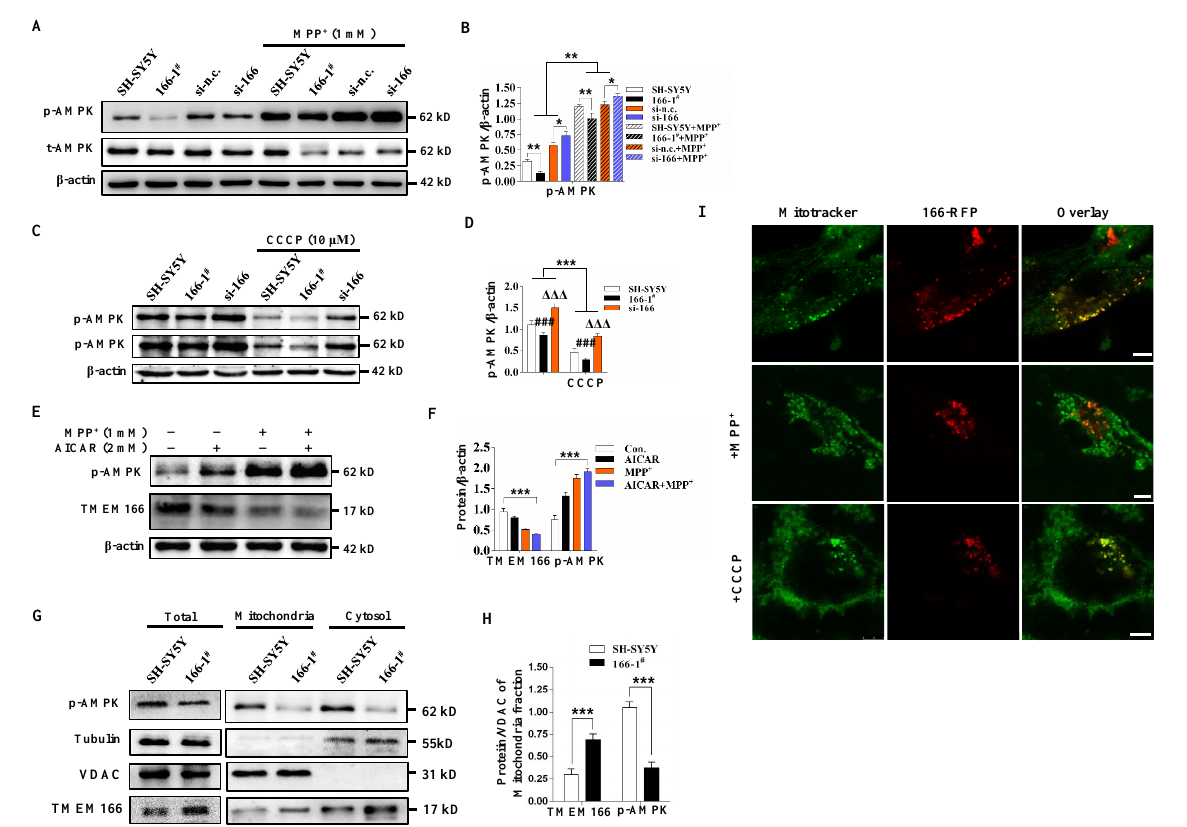
Figure 6. TMEM166 down-regulates AMPK activity in mitochondria. ( A , B ) p-AMPK levels in